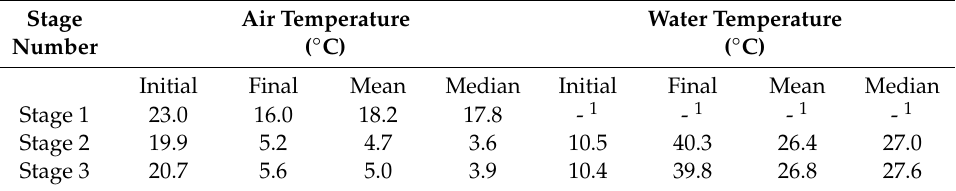
Table 4. Temperature values determined inside the experimental room for all stages of